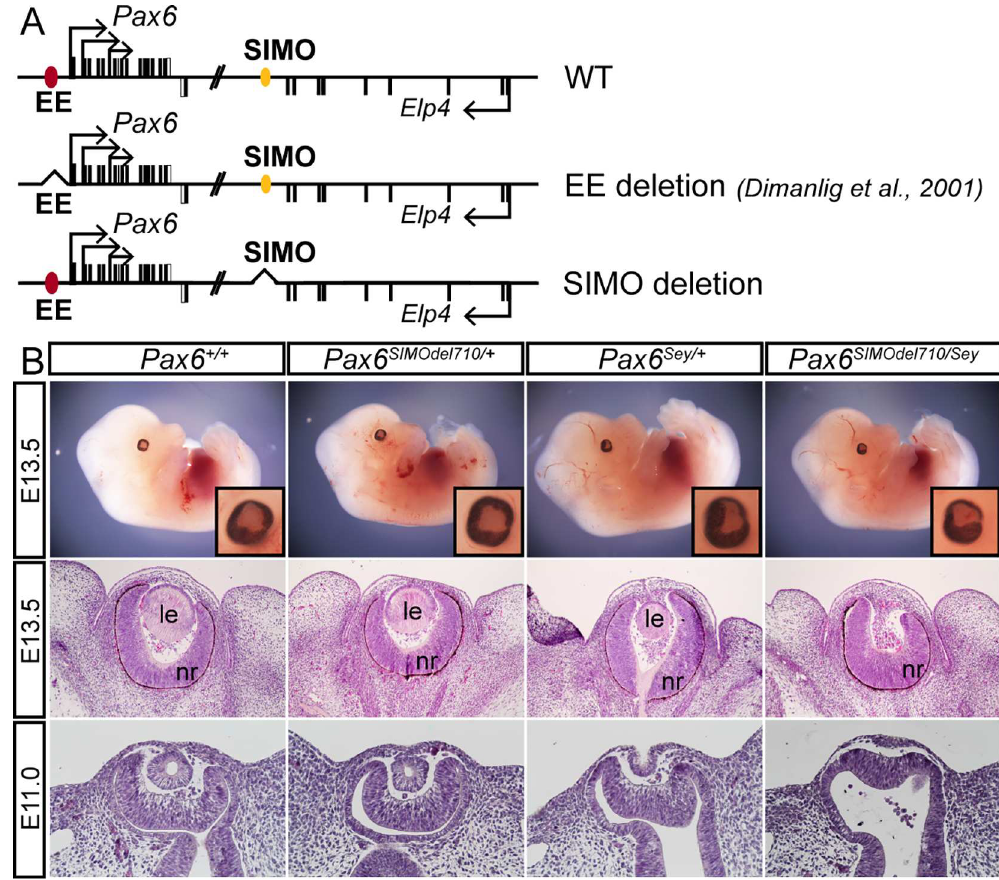
Fig 5. Genetic analysis of SIMO deletion in vivo . ( A ) Scheme of wild-type Pax6 locus and allelescarrying EE [17] or SIMO deletion (this study). EE is indicatedwith red oval and SIMO with yellow oval. ( B ) Phenotypic consequences of SIMO deletionin Pax6 eSIMOdel710/Sey compoundheterozygote mice. Whole-mount view of E13.5 embryos of the indicatedgenotypewith eye in the inset (top panel). Histologicalsections through the eye demonstrating the absenceof lens at E13.5 (middle panel)and arrested development prior to lens pit stage at E11.0 in Pax6 SIMOdel710/Sey embryos. nr—neural retina,